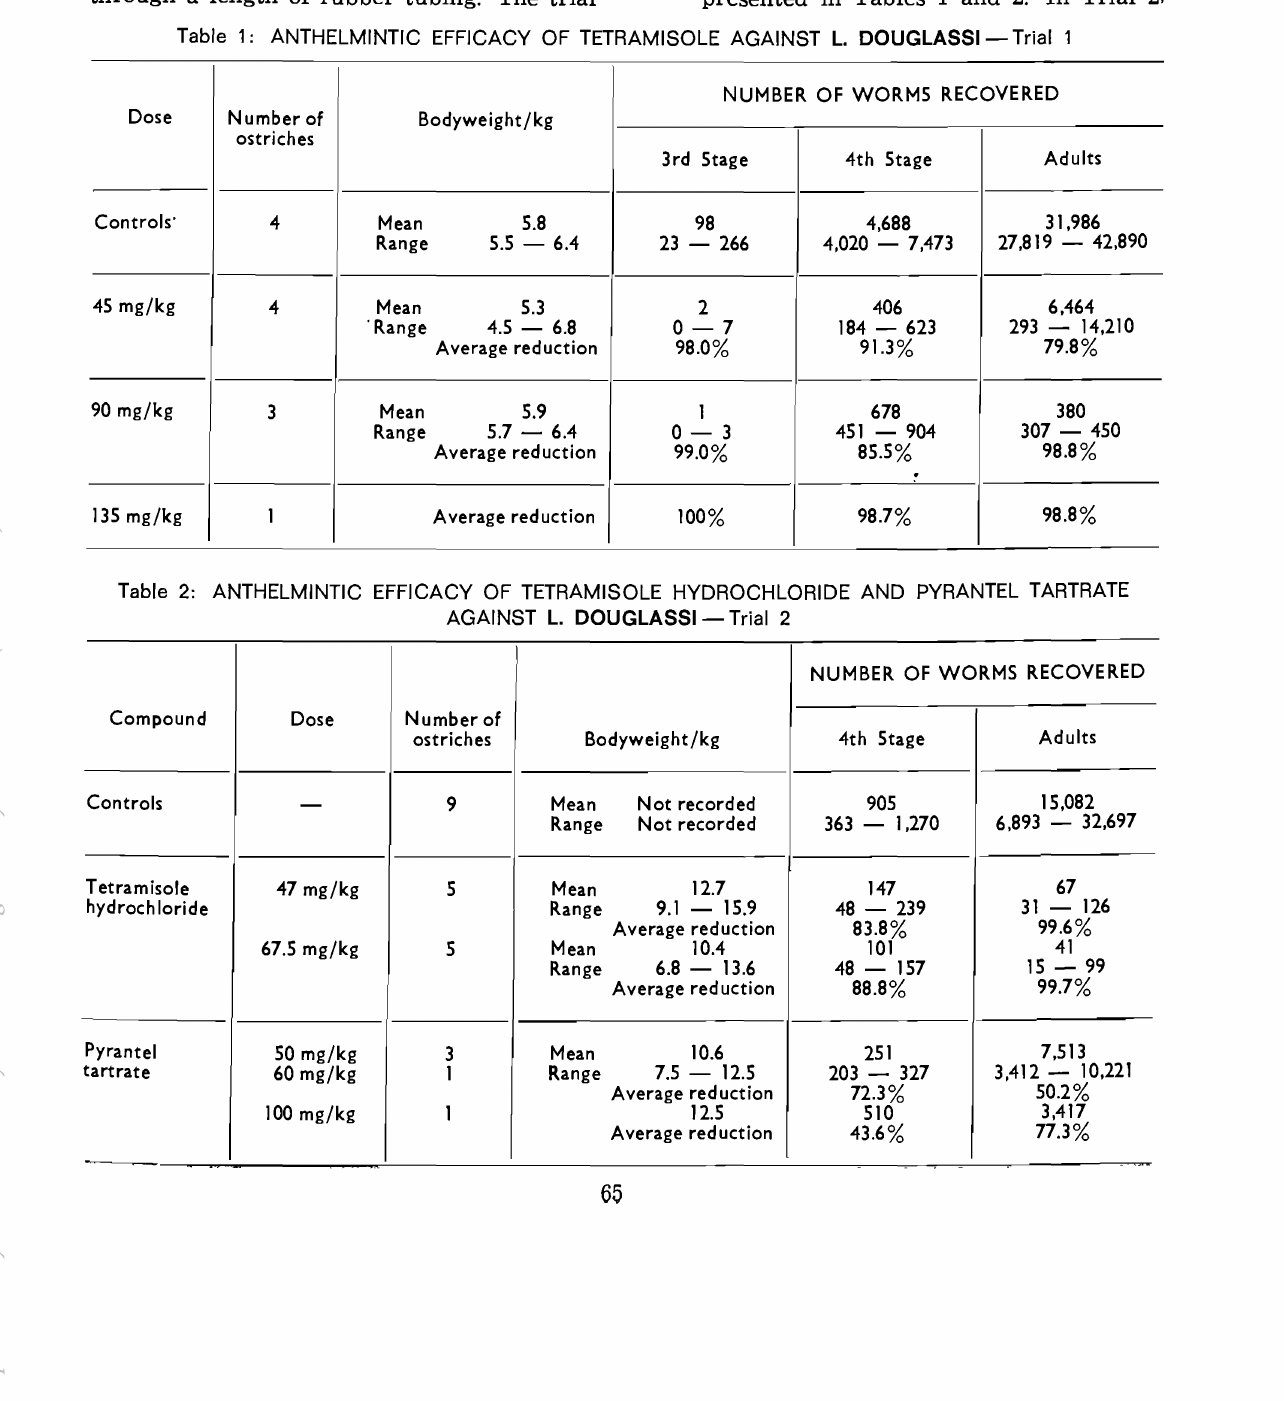
Table 1: ANTHELMINTIC EFFICACY OF TETRAMISOLE AGAINST L. DOUGLASSI- Trial 1